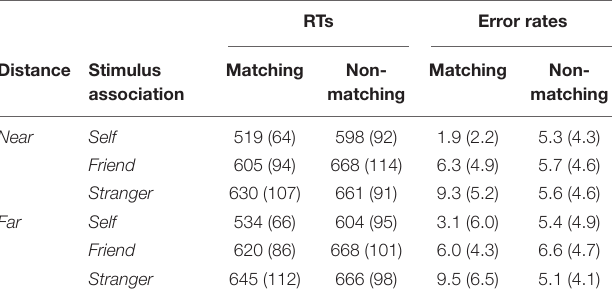
TABLE 2 | RTs (in ms) and error rates (in %) of Experiment 2 as a function of distance, stimulus association, and match (standard deviations in parentheses). RTs Error